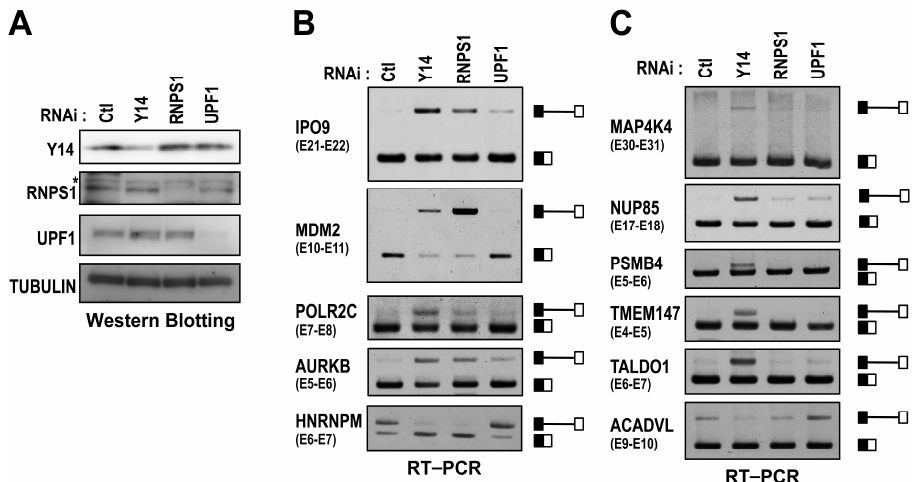
Figure 5. RNPS1 is required for efficient removal of some, but not all, EJC core-responsive introns. ( A ) HeLa cells were transfected with specific siRNAs against Y14, RNPS1, UPF1, or control (Ctl). At 48 h post-transfection, whole cell extracts were subjected to Western blot analysis. The asterisk (*) indicates a non-specific signal; and ( B , C ) total RNAs were isolated and analyzed by RT–PCR using primer sets for MDM2, AURKB and ACTG1 (shown in Supplementary Table S4). The schematic representation on the right of each panel indicates the corresponding unspliced- and spliced-products.